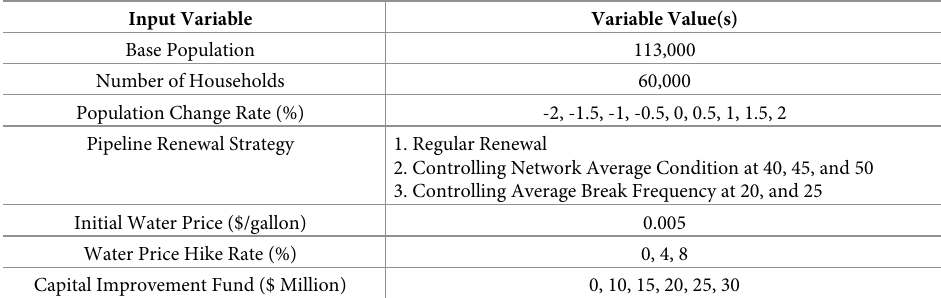
Table 1. Model input